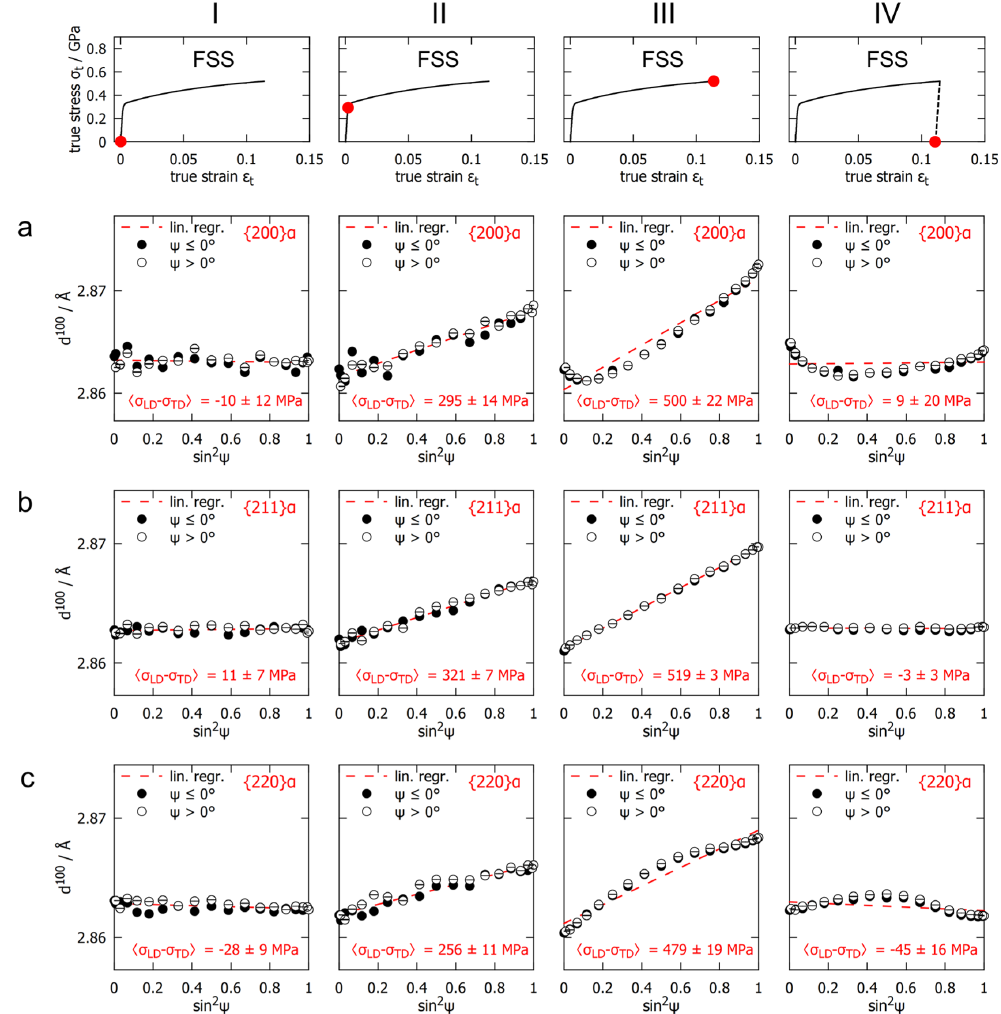
Figure 10. d 100 − sin 2 ψ distributions of ferrite lattice planes { 200 } α ( a ), { 211 } α ( b ) and { 220 } α ( c ) for selected load states during tensile deformation of the FSS: initial state ( I ), macroscopic yield strength ( II ), plastically deformed ( III ), and unloaded after deformation ( IV ); stress differences (cid:104) σ LD − σ TD (cid:105) α determined by linear regression (red dotted line) according to the sin 2 ψ